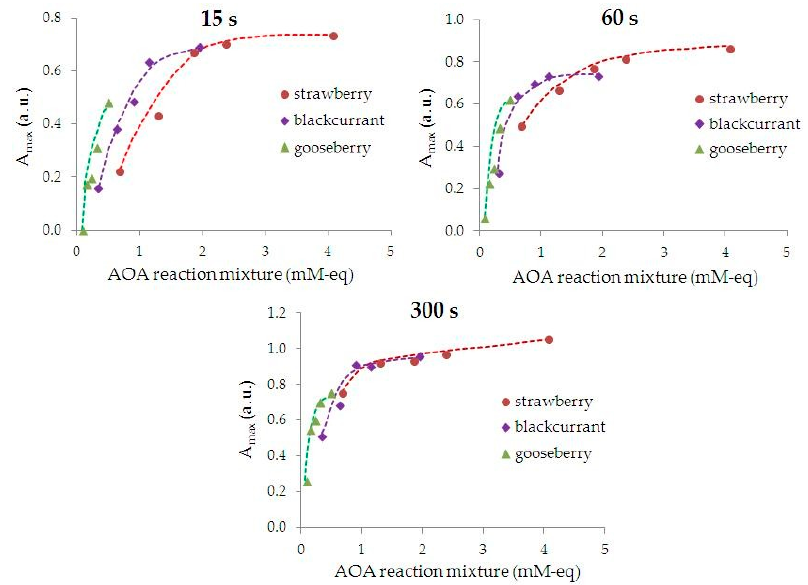
Figure 3. Dependence of phyto-AuNPs suspensions ( A max ) absorption maximum on the AOA of the reaction mixture of the leaf extracts from gooseberry, blackcurrant, and strawberry with different durations of phytosynthesis.